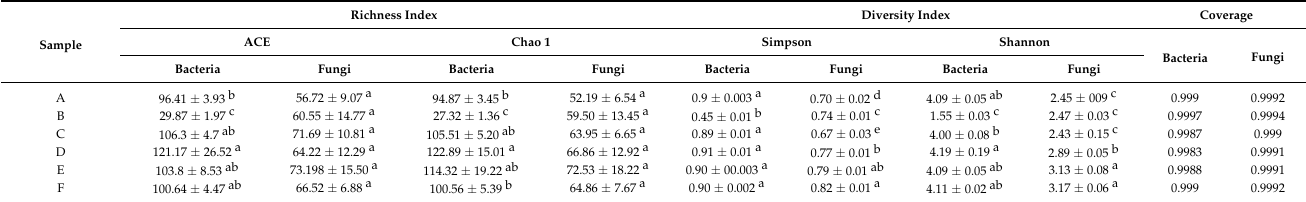
Table 1. Number of sequences analyzed, observed diversity richness (observed OTUs), community richness index (Chao 1 and ACE), community diversity index (Shannon and Simpson), and estimated sample coverage for 16S rDNA and ITS rDNA libraries of CTN samples.